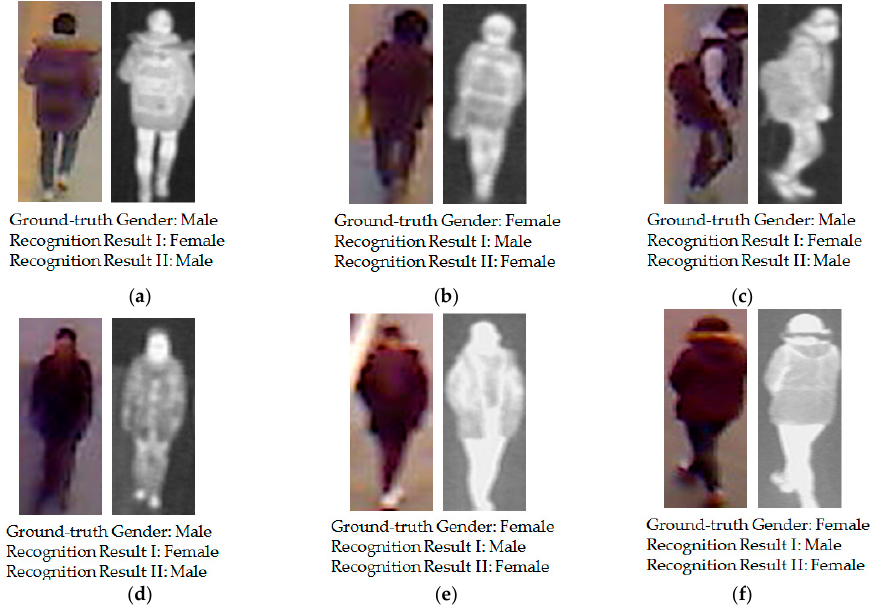
Figure 9. Example recognition results for our proposed method, as compared to the previous recognition method: ( a ) male image in the back view; ( b ) and ( f ) female images in the back view; ( c ) male image in the side view; ( d ) male image in the front view; and ( e ) female image in the front view.